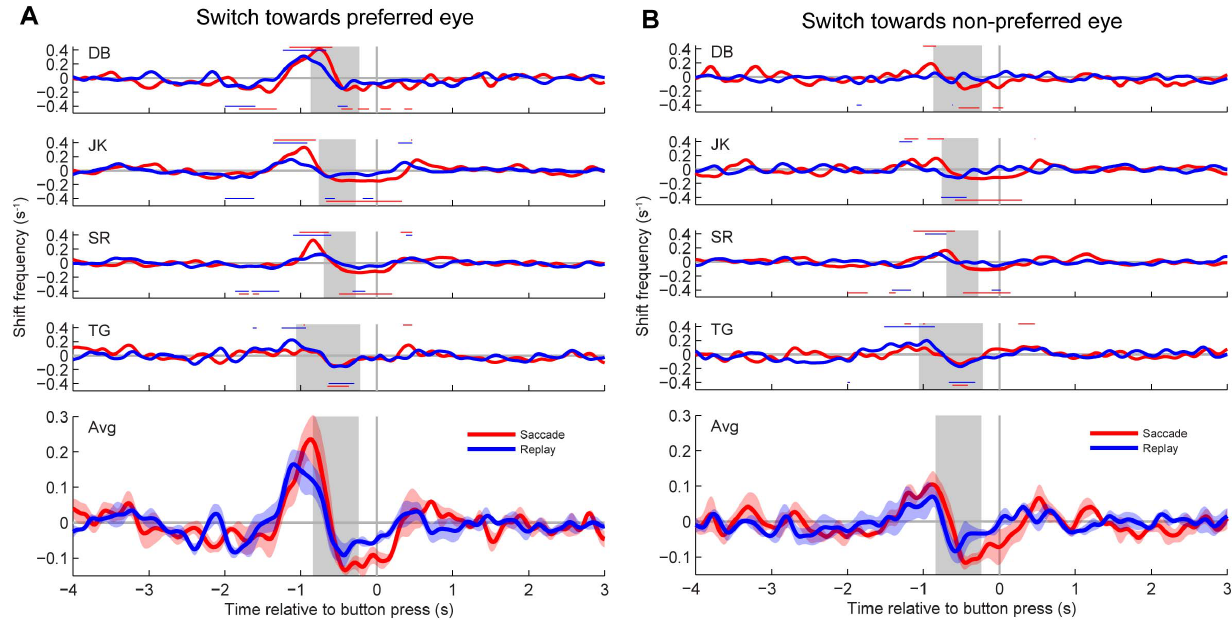
Figure 5. Covariograms of percept switches and large ( . 1 6 ) retinal image shifts. Shifts were produced by saccades (red) or stimulus jumps (blue). A: Switches from the non-preferred to the preferred eye. B: Switches from the preferred to the non-preferred eye. Top panels show the results from individual subjects. Bottom panels plot the mean across all four subjects. Shaded areas denote 6 1 SEM. Gray horizontal lines represent zero deviation from the baseline shift predictor (c.f., Methods, Figure 2). The vertical gray bar is an estimate (mean 6 SD) of the moment that the actual percept switch occurred relative to the moment of the button press (i.e., the reaction time obtained from the stimulus flip condition in control experiments). Red and blue horizontal lines above the graphs from individual subjects indicate a significant peak in that time window for saccade or stimulus jump frequency, respectively; similarly, red and blue lines underneath the graphs indicate significant troughs. (BE-test, p , 0.05).